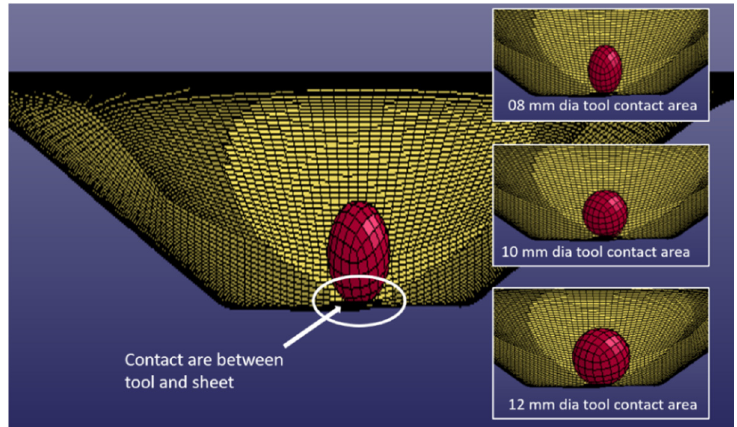
Figure 13. A contact area between tool and sheet for different tool diameters .